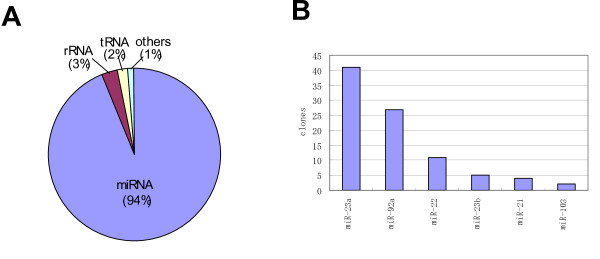
Categories of cDNA clones derived from immunoprecipitated small RNA of HeLa cells. A: Composition of small RNA cDNA clones. The composition of cDNA clones is shown in a circle graph. Almost all of the recovered cDNA was miRNA (94%), while the remainder was rRNA and tRNA clones (3% and 2%). 'Others' indicates the cDNA clones with hits in the genomic sequence. B: Contents of miRNA clones. Each miRNA clone was deduced by BLAST search. The y-axis indicates number of clones of each miRNA species.